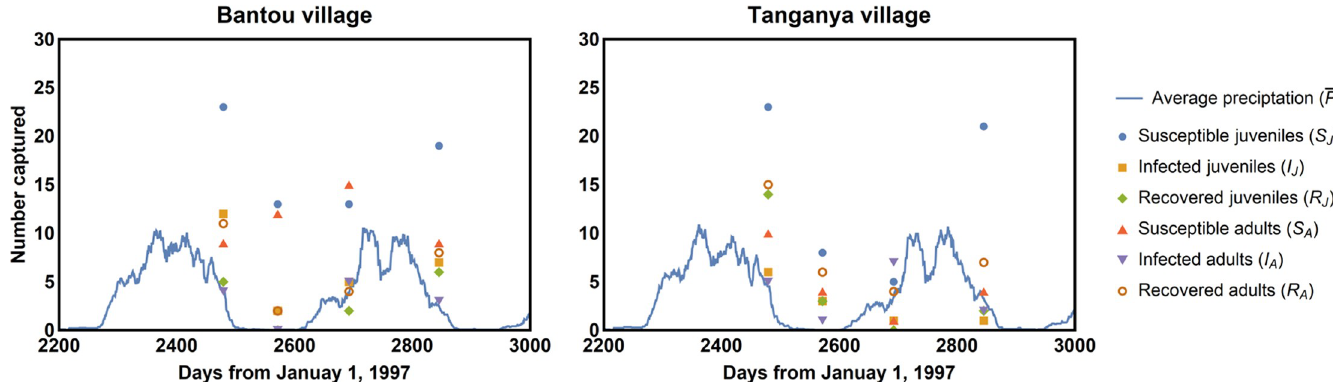
Fig 1. Time series data for the number of M . natalensis individuals captured within two villages in Guinea over four trapping sessions occurring between 2002– 2005 (colored symbols). The blue lines indicate the 30-day average precipitation values for each village. M . natalensis capture data comes from the study described in [6, 14] and precipitation data comes from the CHIRPS 2.0 database. Although the original rodent trapping study included two additional dates, one of these is not shown because complete data on all classes was absent and the other is not shown and was not used due to a substantially reduced trapping effort we believed could compromise